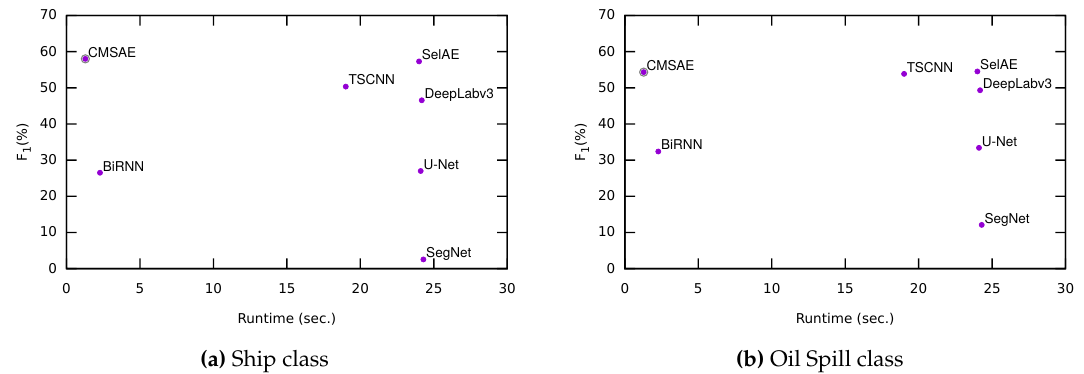
Figure 10. Comparison of the result obtained from a Multi-objective Optimization Problem (MOP) perspective, comparing the result of the classification and the runtime for the ship and oil spill